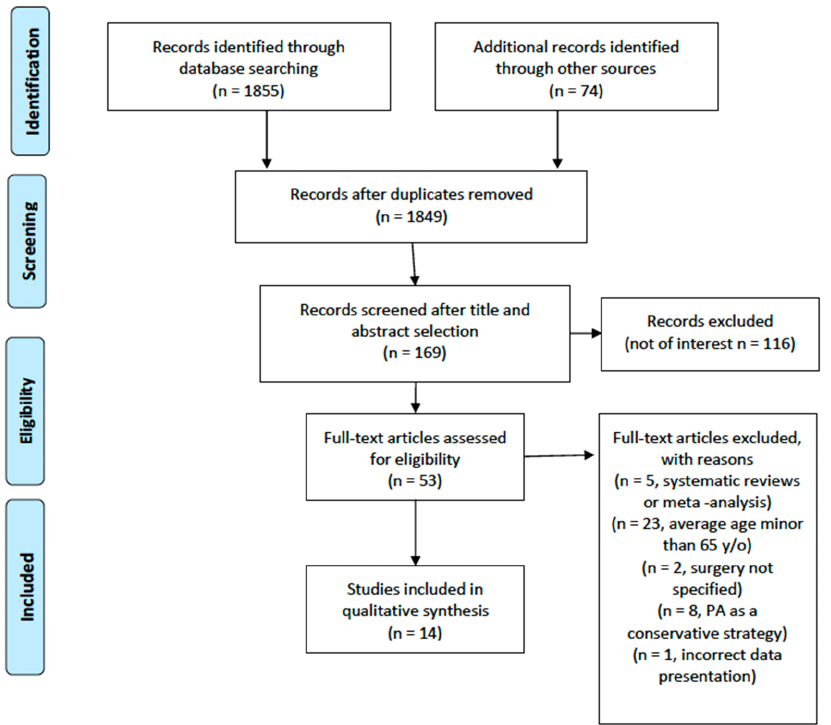
Figure 1. Preferred Reporting Items for Systematic Review and Meta-analysis (PRISMA) flow diagram. PA: Physical Activity